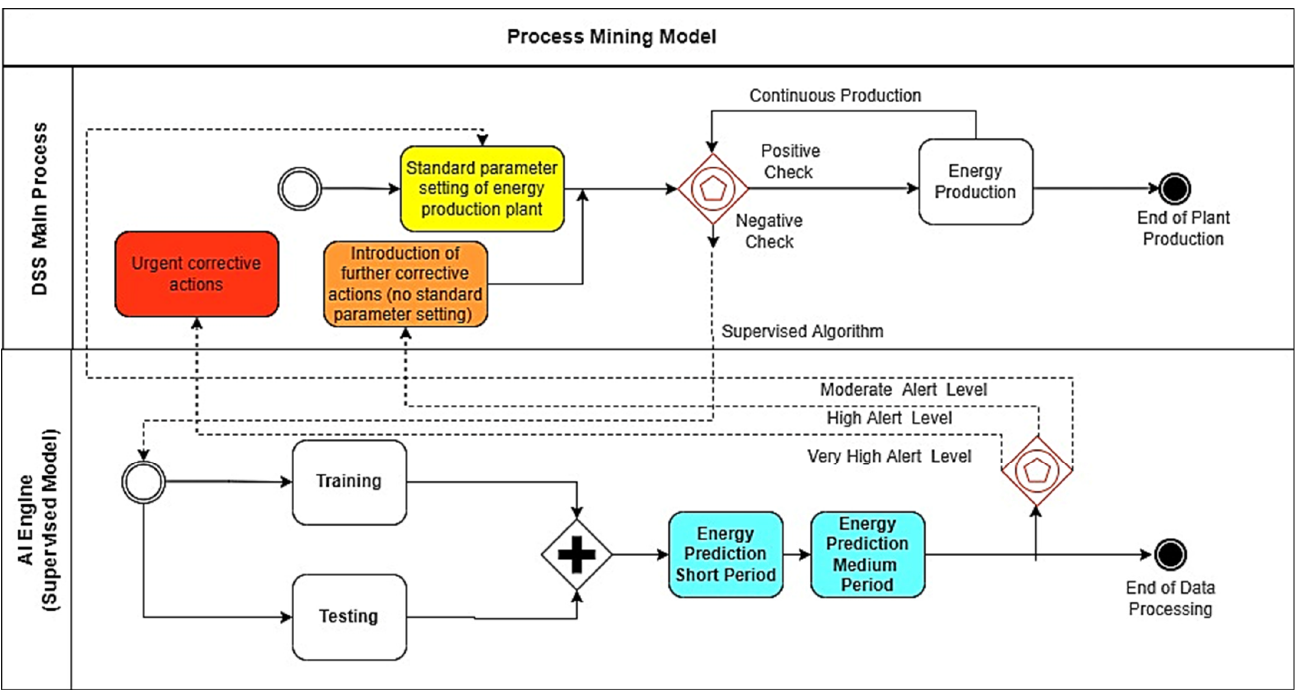
Figure 8. BPMN workflow modeling PM applied to CCPP plant and matching with energy power prediction.